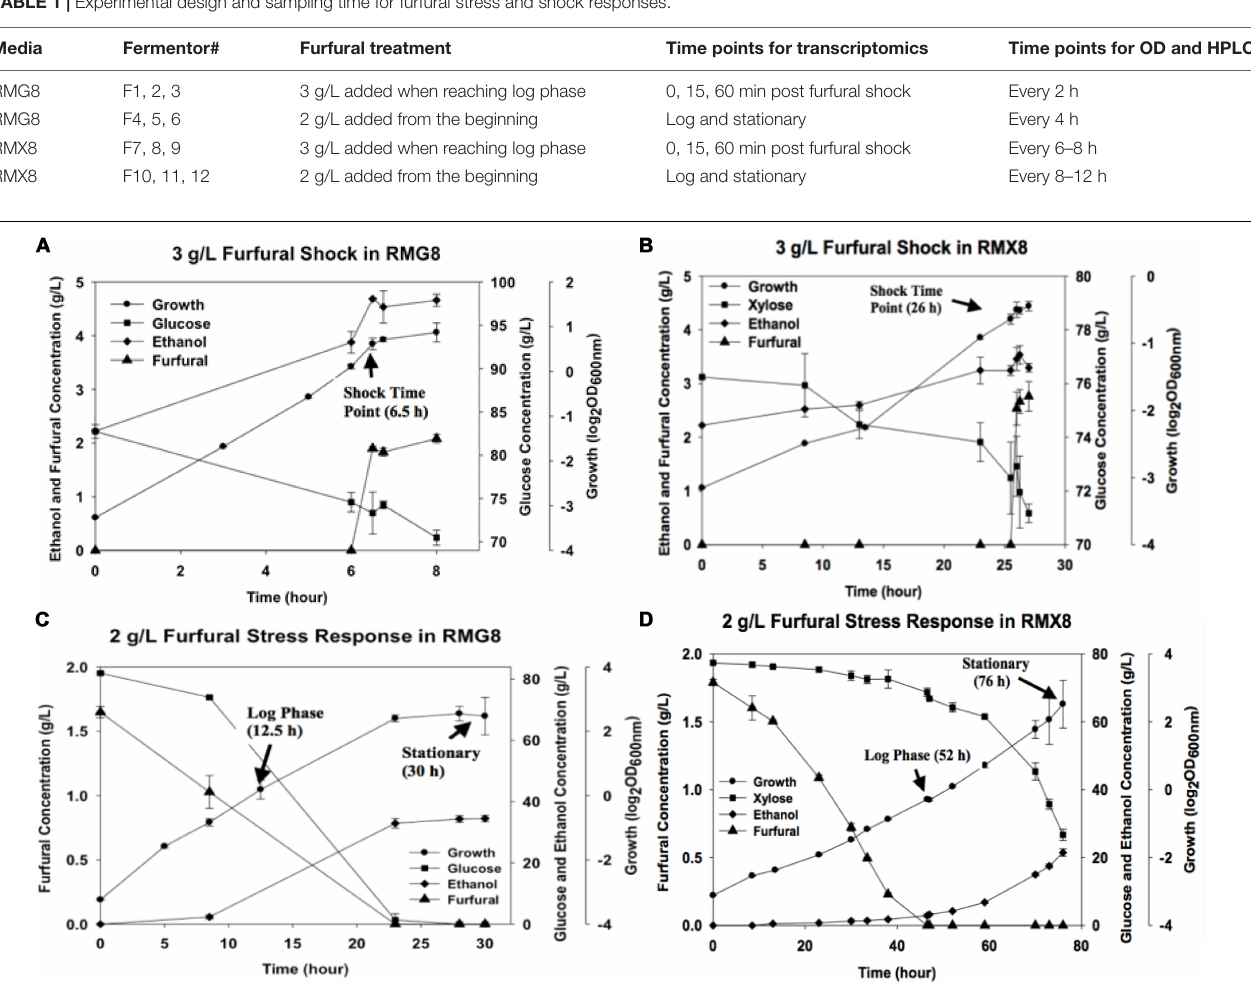
( Supplementary Figure S4C and Supplementary Table S3-12